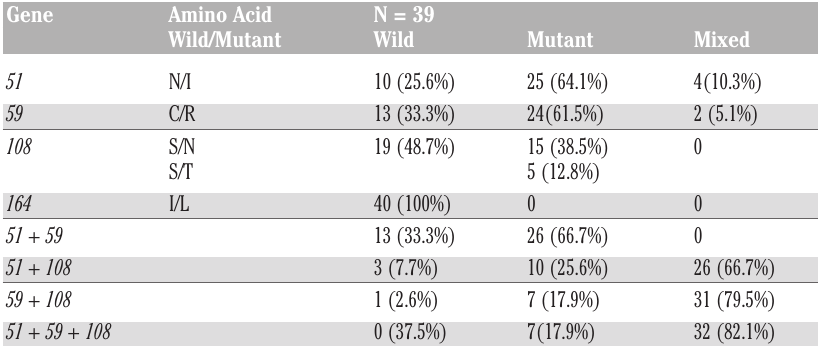
Table 2. Prevalence of dhfr mutations in P. falciparum isolates obtained from pregnant women in Ilorin,